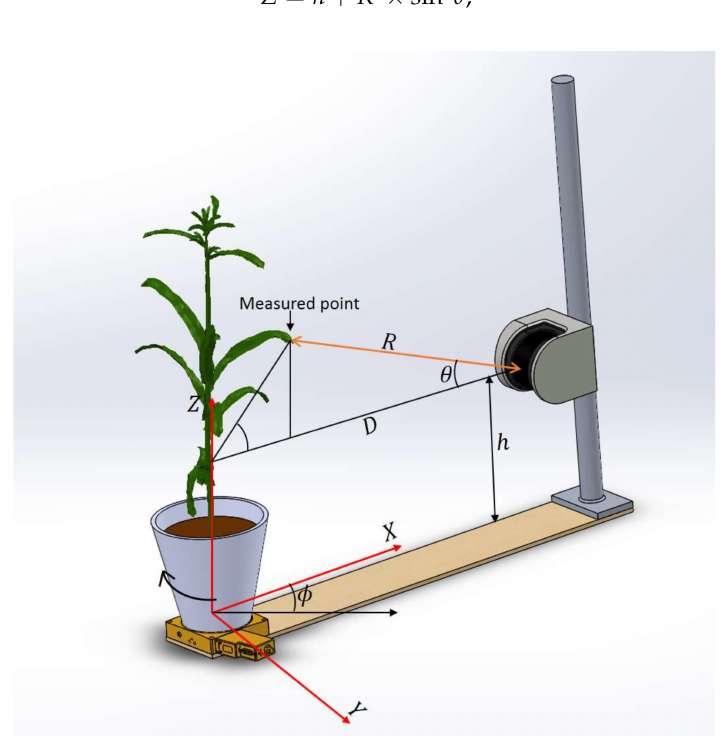
Figure 2. Coordinate system used to convert the range values from the LiDAR to Cartesian